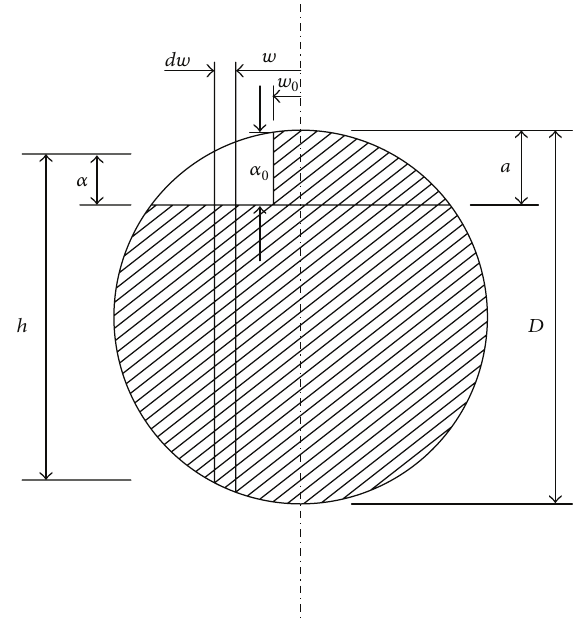
Figure 3: Cross section at crack location